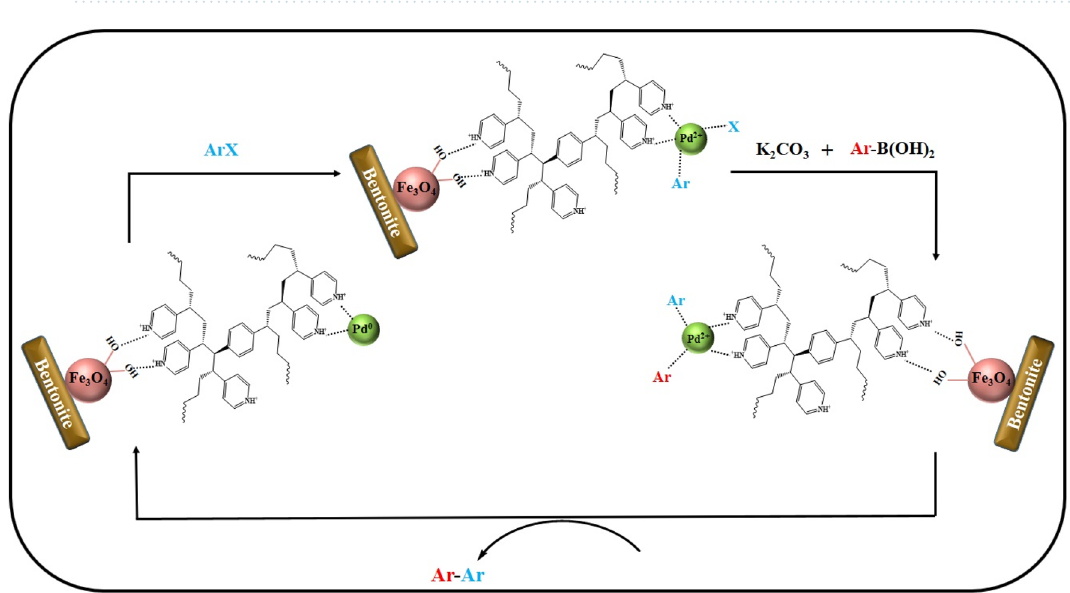
Figure 2. A possible mechanism of Suzuki coupling reaction catalyzed by Fe-Ben /PVP-DVB/Pd